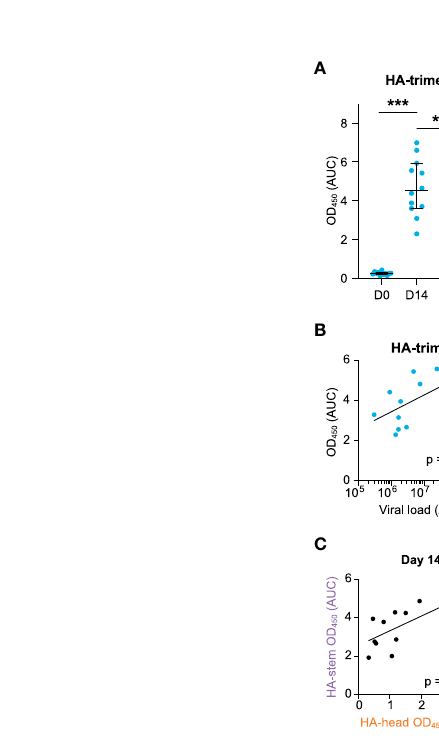
FIGURE 1 HA-antibody responses to H1N1 pdm2009 at day 0, 14, and 56 post-infection (A) Antibody response measured in serum in time against the HA- trimer (blue), HA-head (orange), and HA-stem (purple) domains, calculated as area under curve (AUC), median and 95% CI are depicted (B) Correlation between cumulative viral load in tracheal swabs (AUC) and antibody responses against HA-trimer (blue), HA-head (orange), and HA- stem (purple) domain measured at day 56. (C) Correlation between HA-head and HA-stem antibody responses at day 14 (left) and day 56 (right). Statistical differences between two groups were determined using the Wilcoxon test (p values: *p < 0.05; **p < 0.01; ***p < 0.001) and correlations were determined using a Spearman correlation test (ns, not signi fi